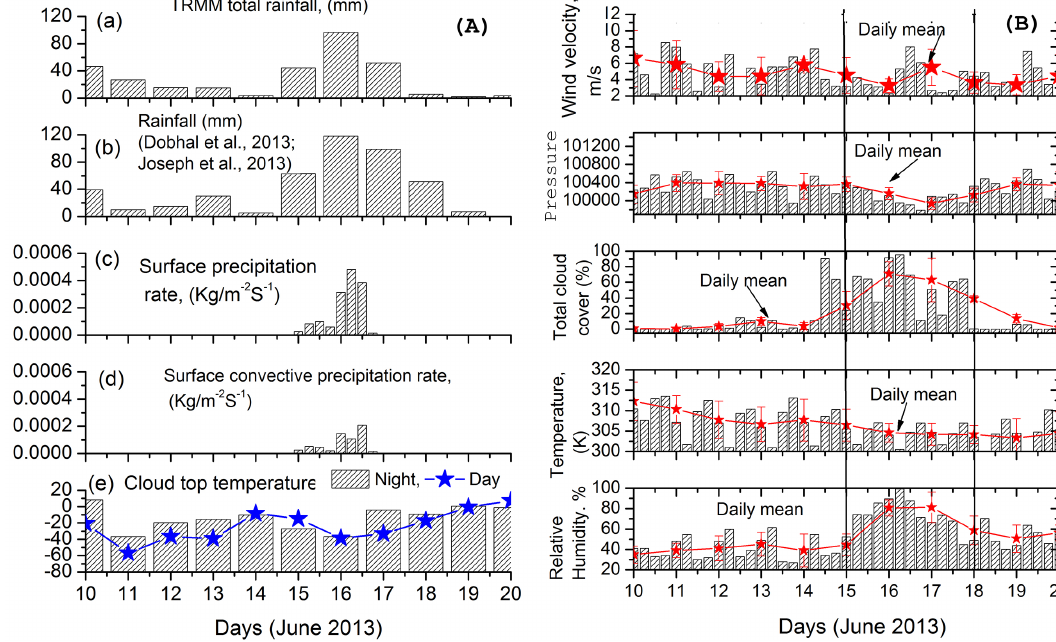
Figure 2. (a) Variation of daily mean (a) TRMM total rainfall (b) rainfall (Dobhal et al., 2013), (c) surface precipitation rate, (d) surface convective precipitation rate, and (e) cloud-top temperature (day/night) for the period 10–20 June 2013. (b) Variation of 6 hourly mean (black line) and daily mean (stars, in red) of meteorological parameters such as wind velocity, atmospheric pressure, total cloud cover percentage, surface temperature and relative humidity for the period 10–20 June 2013 for the selected